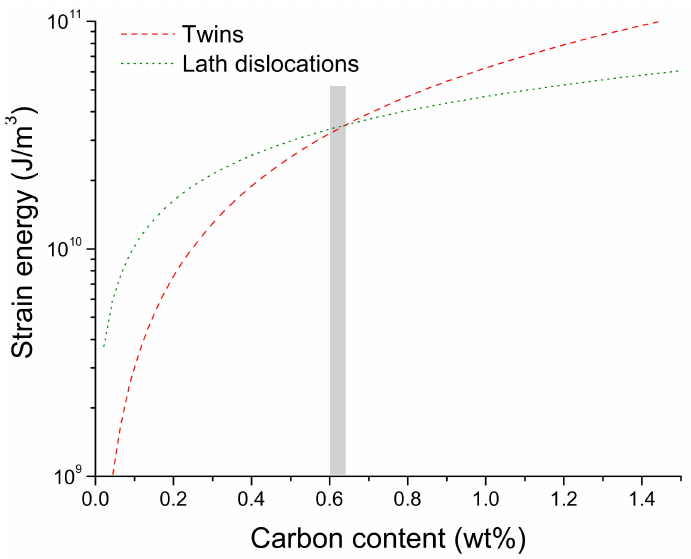
Figure 8. Strain energy per unit volume accommodated by lath dislocations and twins as a function of the total carbon